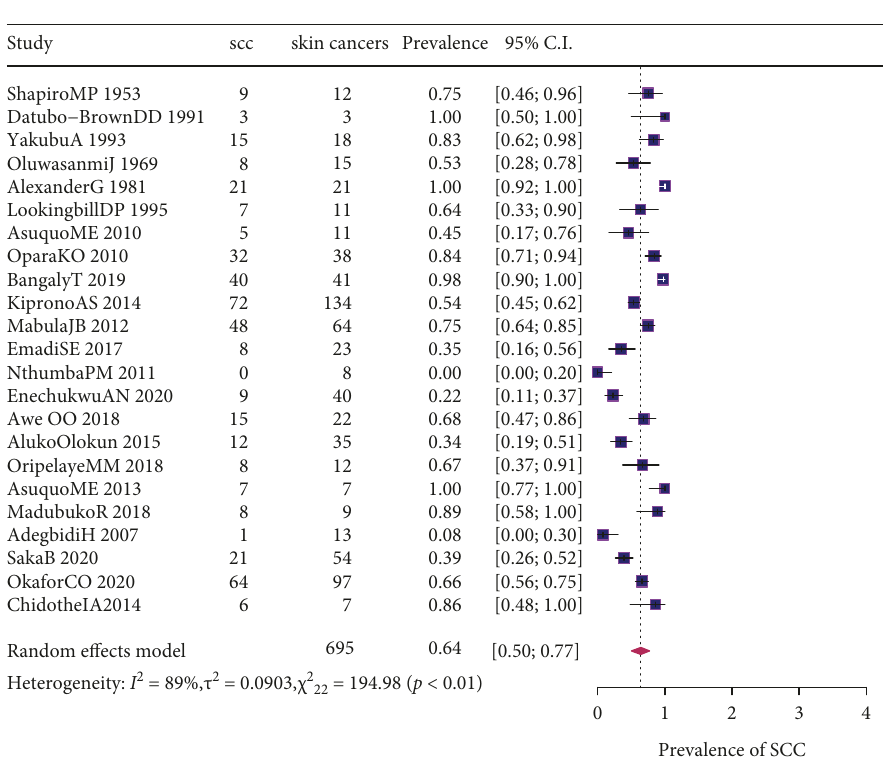
Some patients presented multifocal cancers: